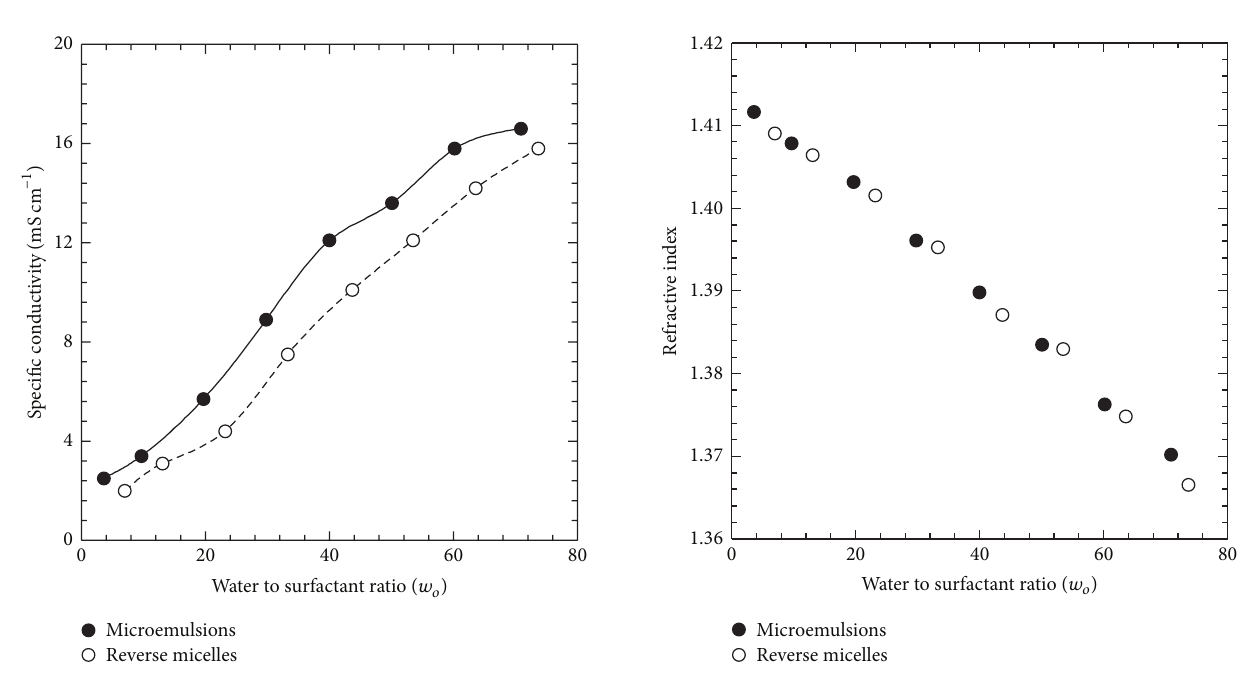
Figure 5: Specific conductivities of CTAB/1-butanol/cyclohexane/ water microemulsions and CTAB/1-butanol/water reverse micelles.